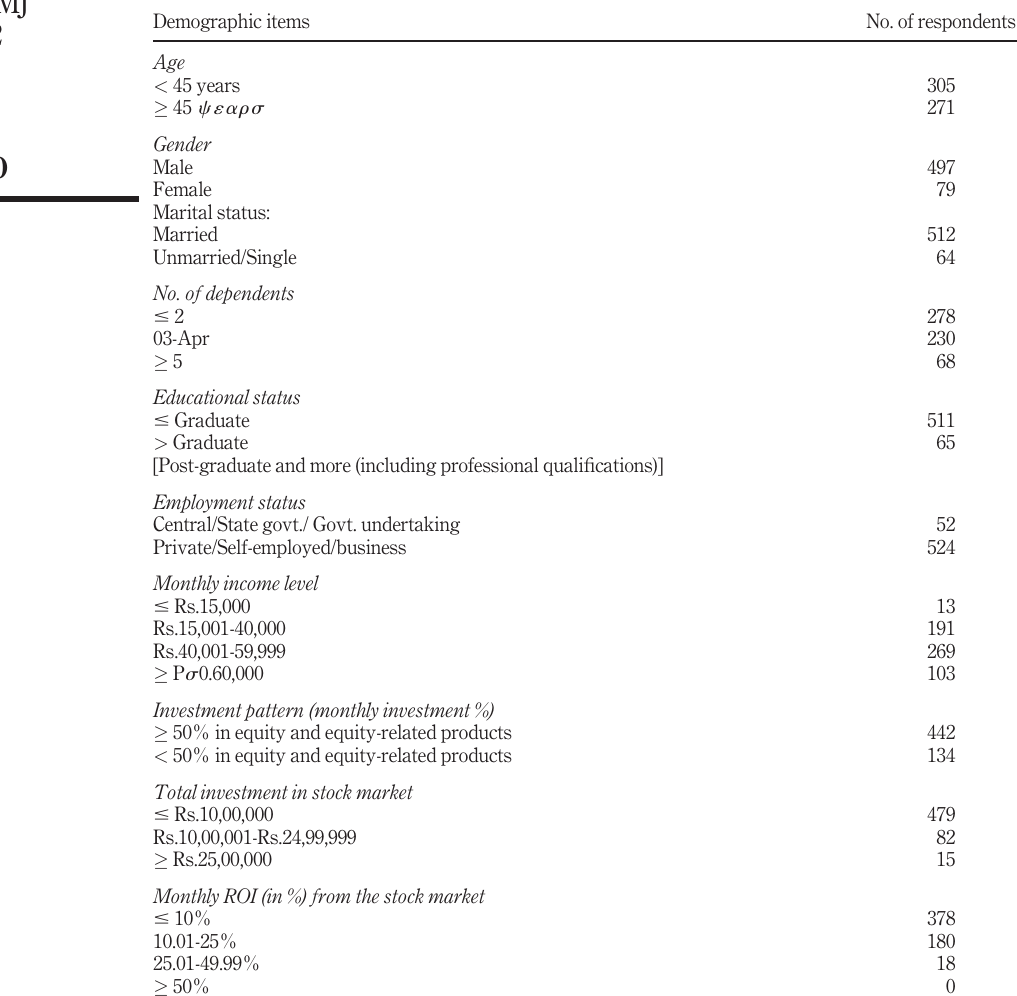
Table 1. Demographic data